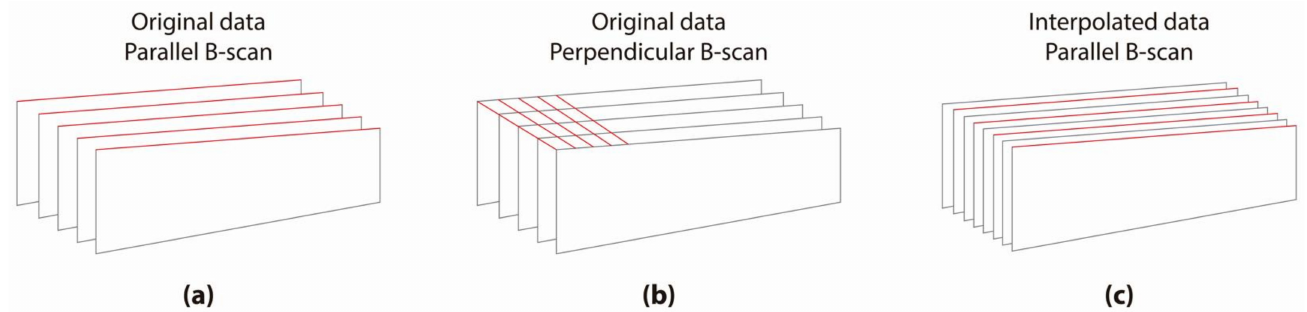
Figure 5. Arrangement of the 3D GPR data matrix: ( a ) the parallel orientation of the original B-scans inserted in the 3D data matrix; ( b ) perpendicular direction of the B-scans, after 90 ◦ rotation, with the data ready to be interpolated; and ( c ) the parallel orientation of the B-scans, after interpolation and a new 90 ◦ rotation, to restore the original reference